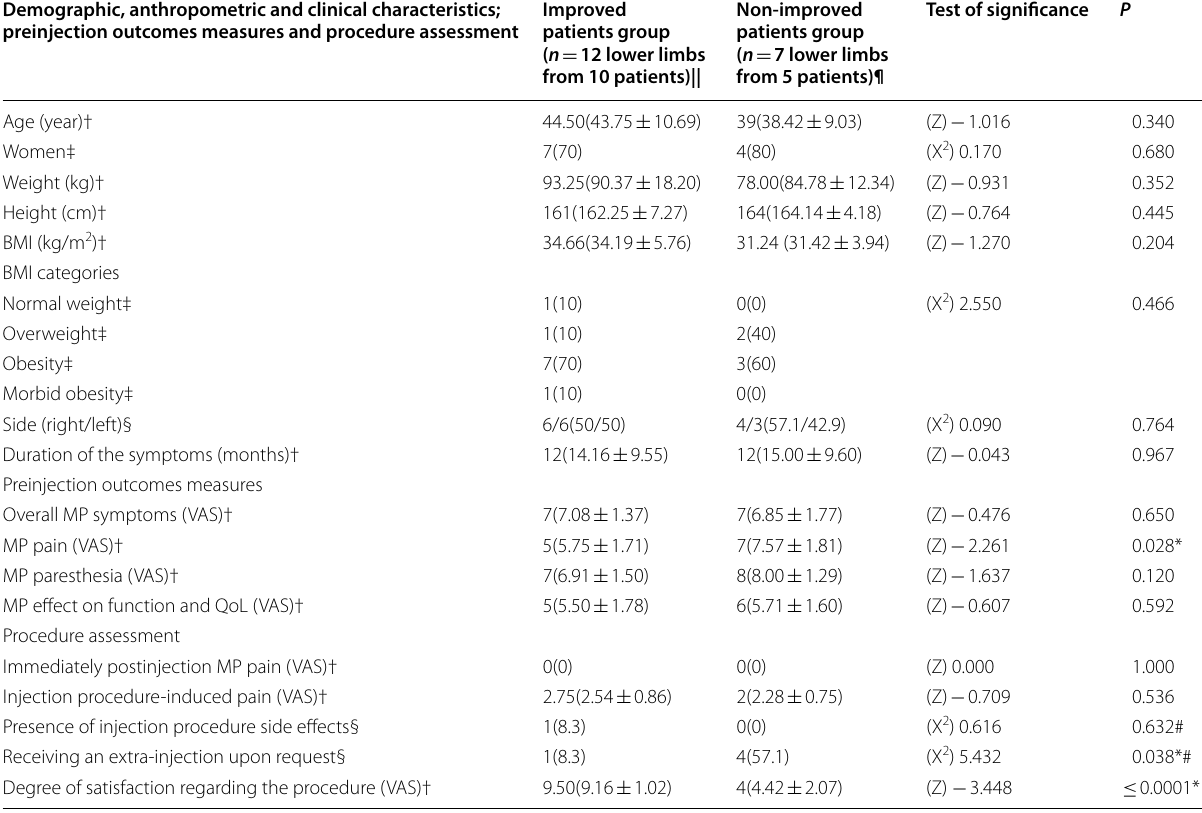
Table 3 Comparison between the improved patients group versus non-improved patients group regarding different assessed